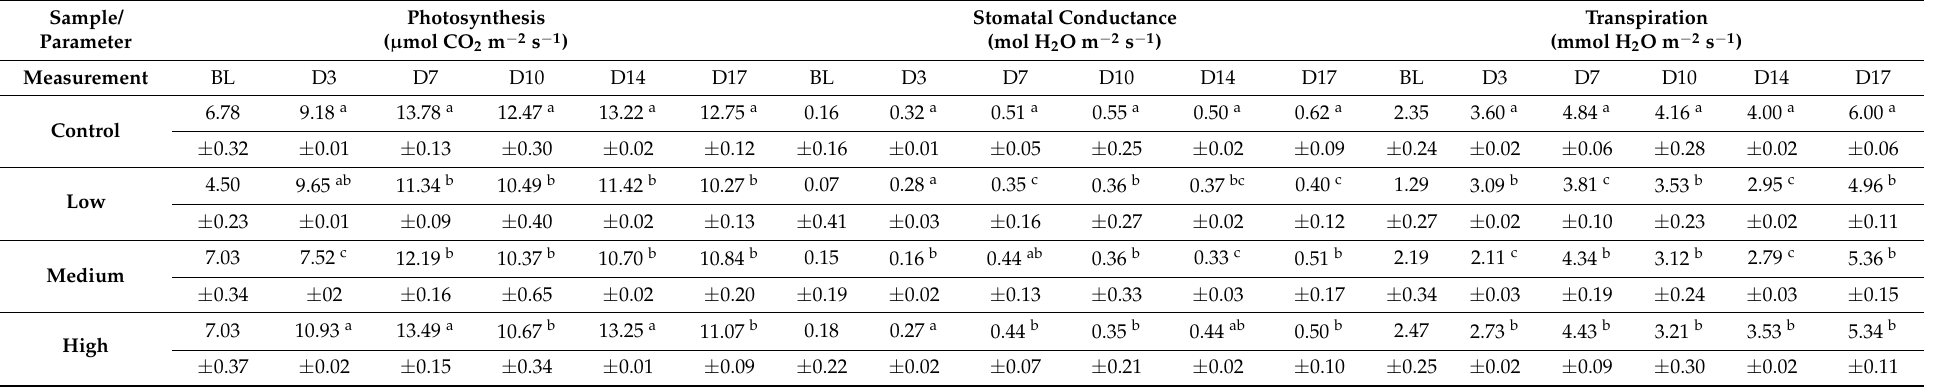
Table 1. Results from the physiological data of the four treatments. Numbers on the top represent the mean values, while numbers at the bottom are the standard error. Sample/ Parameter